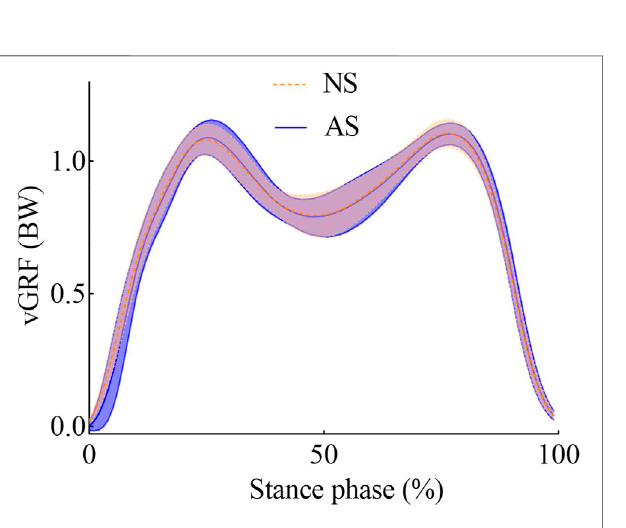
FIGURE 2 | Vertical GRF for NS and AS during stance.